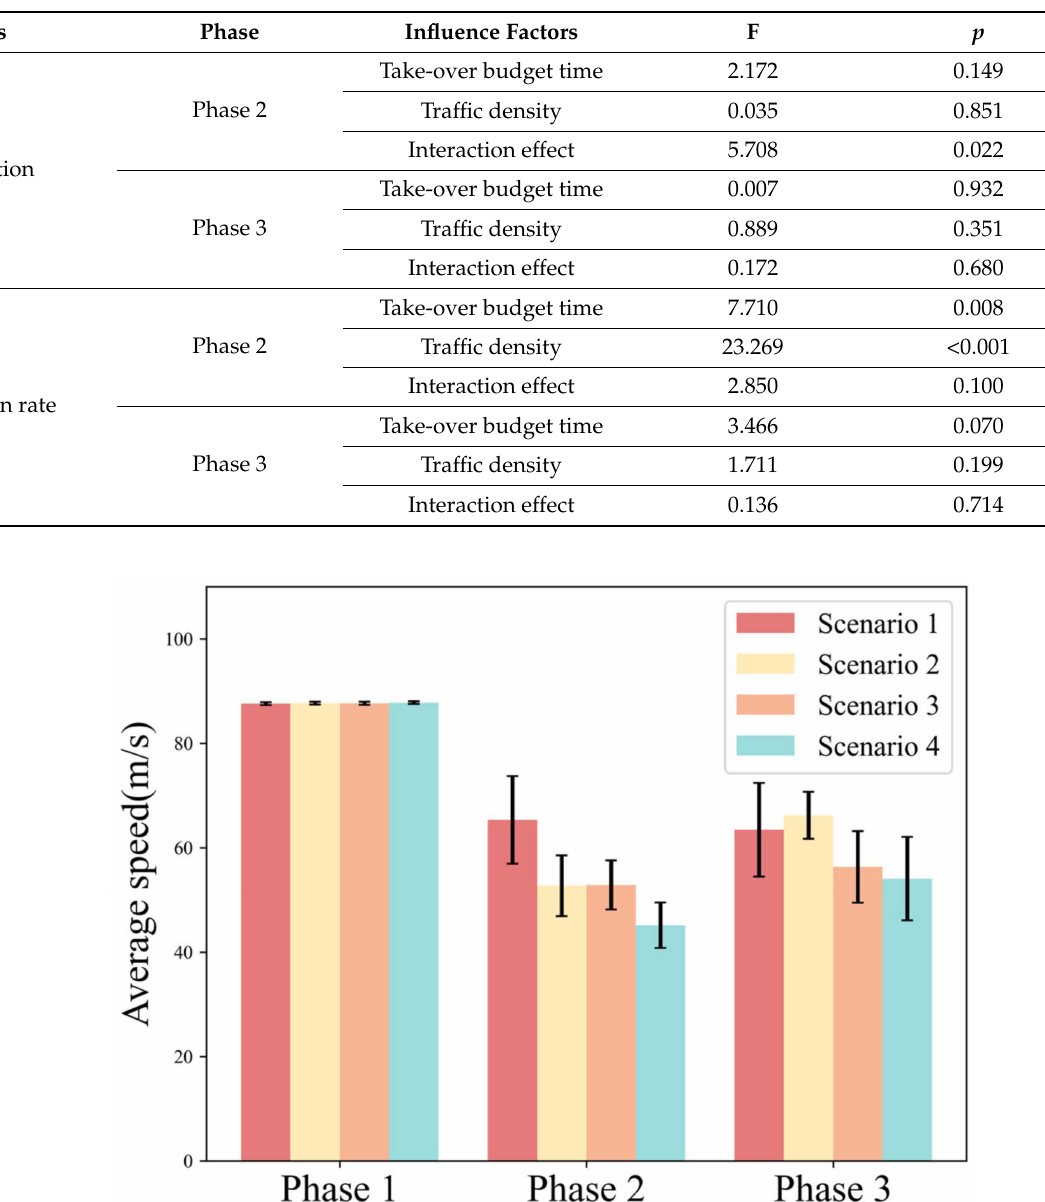
Table 3. Influence of take-over budget time and traffic density on lateral dynamics parameters.